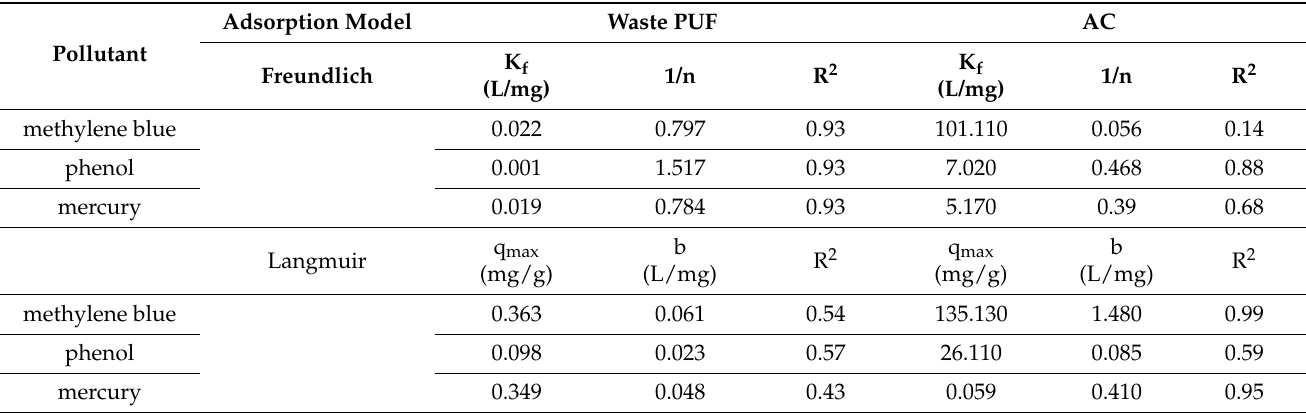
Table 4. Values of Freundlich (K f , n) and Langmuir (q max , b) isotherm models’ parameters resulting from the interpolation of the experimental data derived from batch adsorption tests with waste PUF and AC.